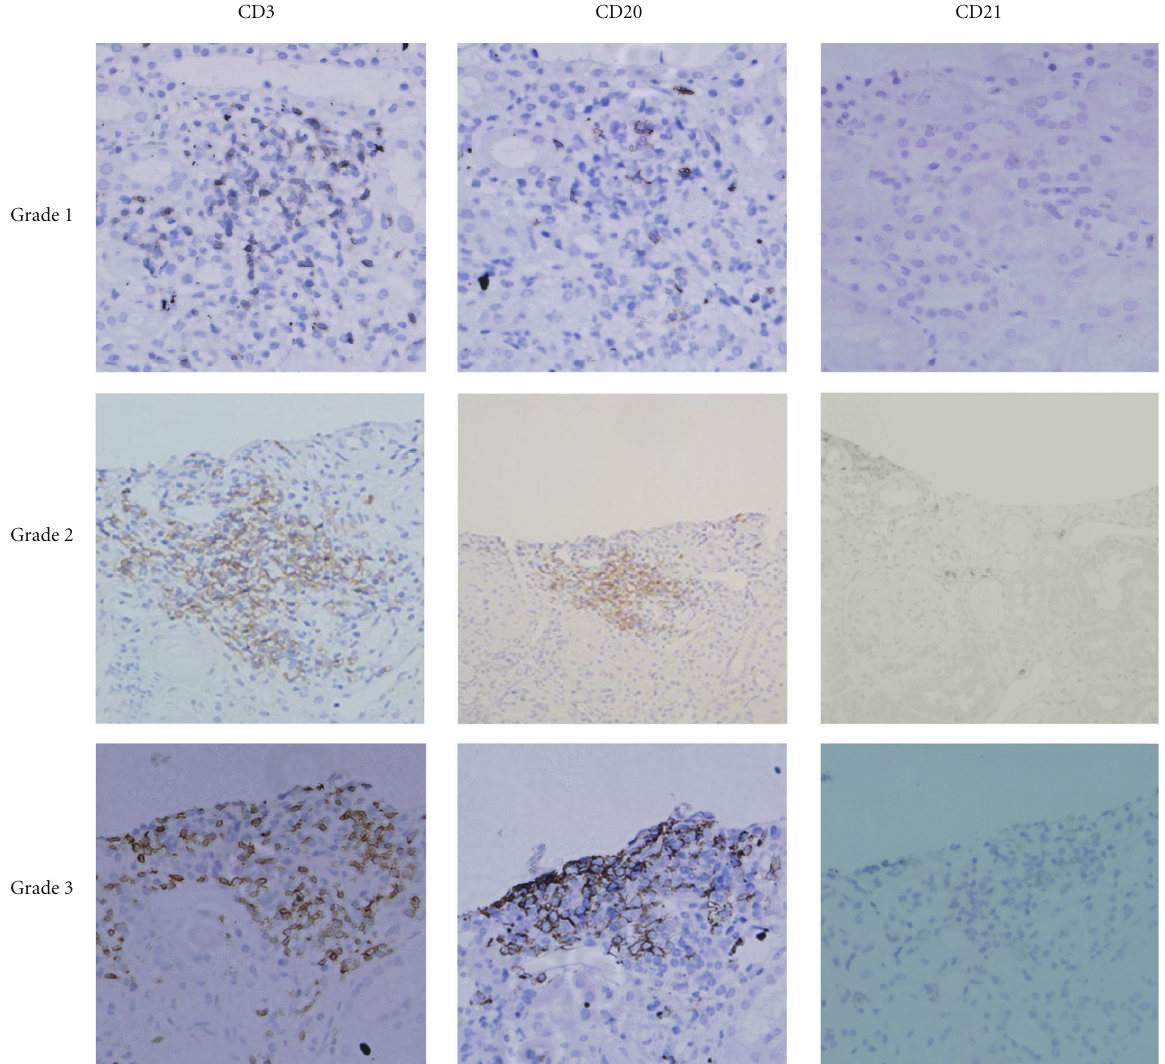
Figure 1: Microanatomical organization of inflammatory infiltrates. Serial staining for CD3, CD20, and CD21 allowed classification into four di ff erent grades. Grade 0 aggregates consist of T cell infiltrates alone (no B cells) (not shown). Grade 1 aggregates consist of scattered T- and B-cell infiltrates (original magnification: × 400). Grade 2 aggregates show a cluster-like structure. No T- and B-cell zones are evident. Grade 3 aggregates show clearly distinguishable T- and B-cell areas (original magnification: ×